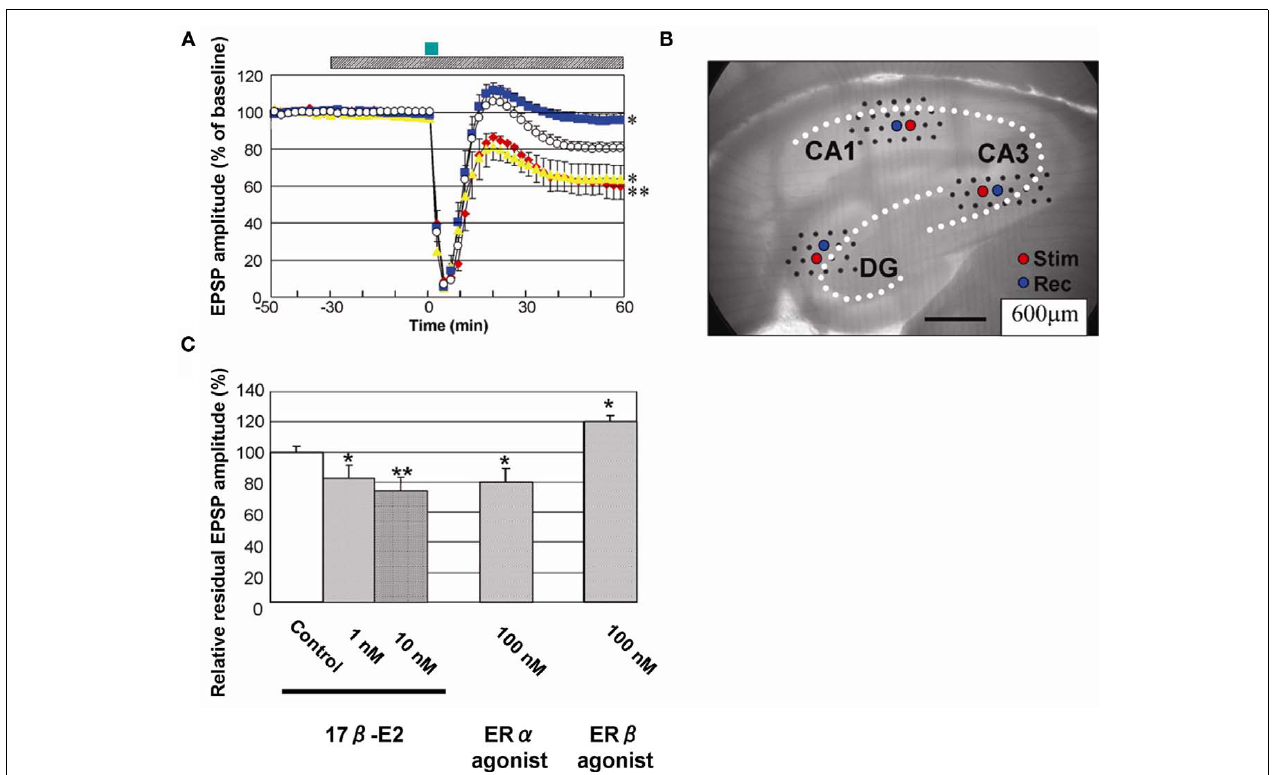
multielectrode probe (MED64, Panasonic, Japan) with the hippocampal slice. Stimulation (red circle) and recording (blue circle) electrodes are indicated. (C) Comparison of modulation effect of 17 β -E2 and agonists on LTD in CA1.Vertical axis is relative EPSP amplitude at t = 60min, where EPSP amplitude of the slice without drug application (control) is normalized as 100%. From left to right, the group applied 17 β -E2, PPT (ER α agonist) and DPN (ER β agonist) at indicated concentration. Statistical significance was calculated at 60min by ANOVAs (* p < 0.05; ** p < 0.01). Modified from Mukai et al. (2007), Hojo et al.